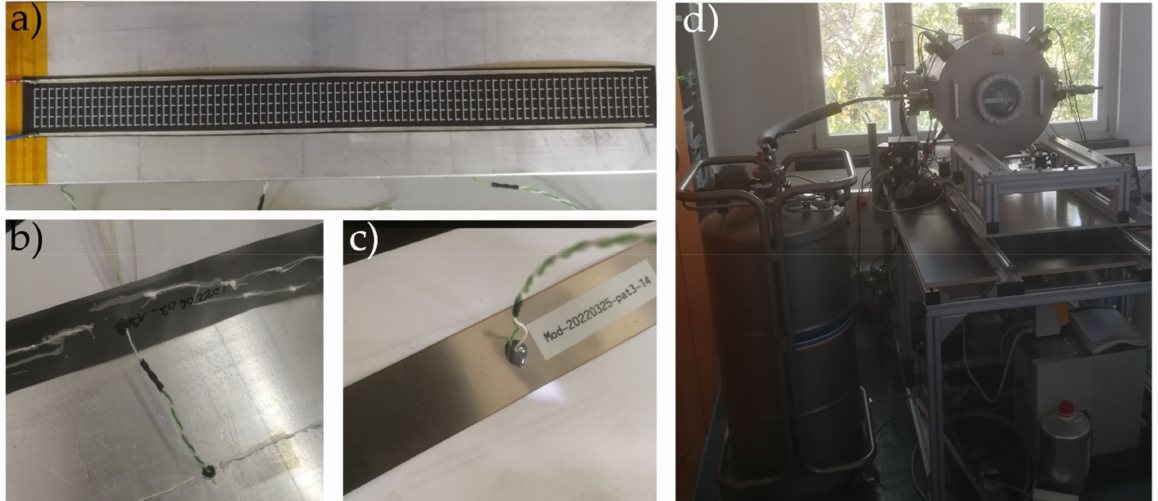
Figure 10. Sample preparation: ( a ) PTS submodule mounted on the thermal plate of the SoSi setup; ( b ) application of thermal paste; ( c ) curing joint between thermocouple and sample; ( d ) LN 2 Dewar container connected to vacuum